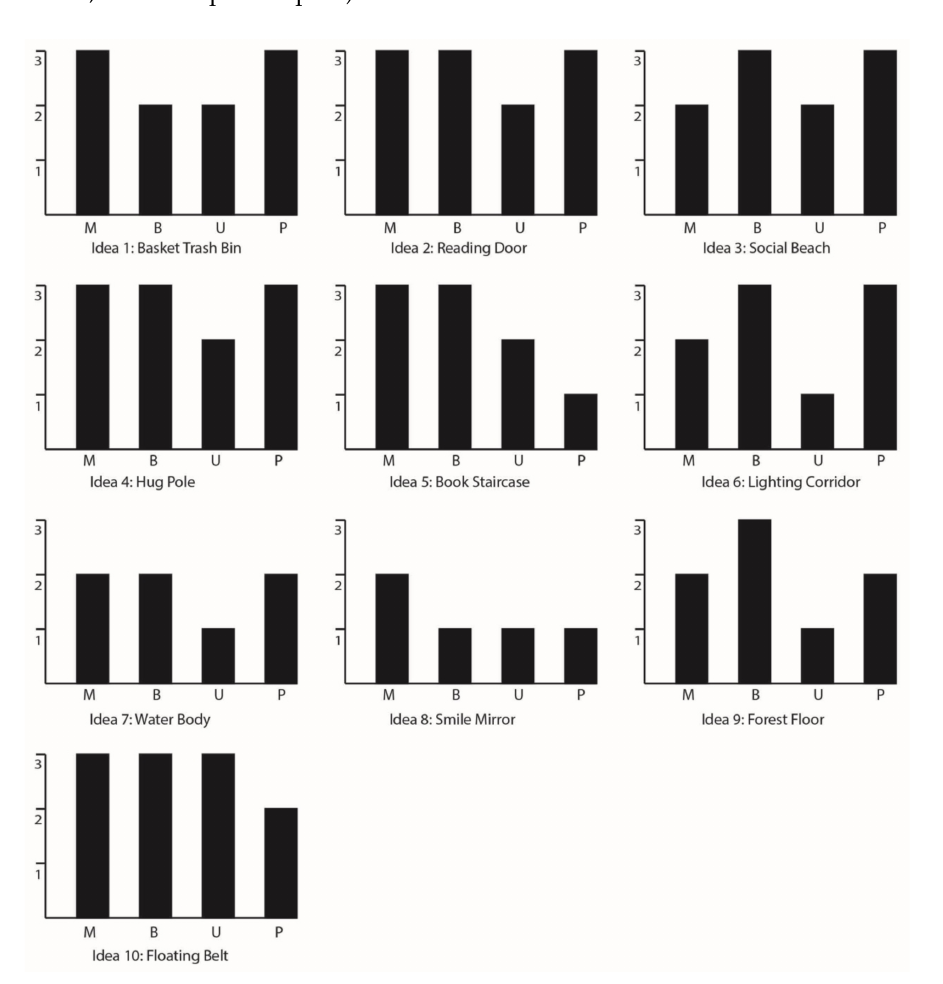
Figure 6. Overall analysis of design